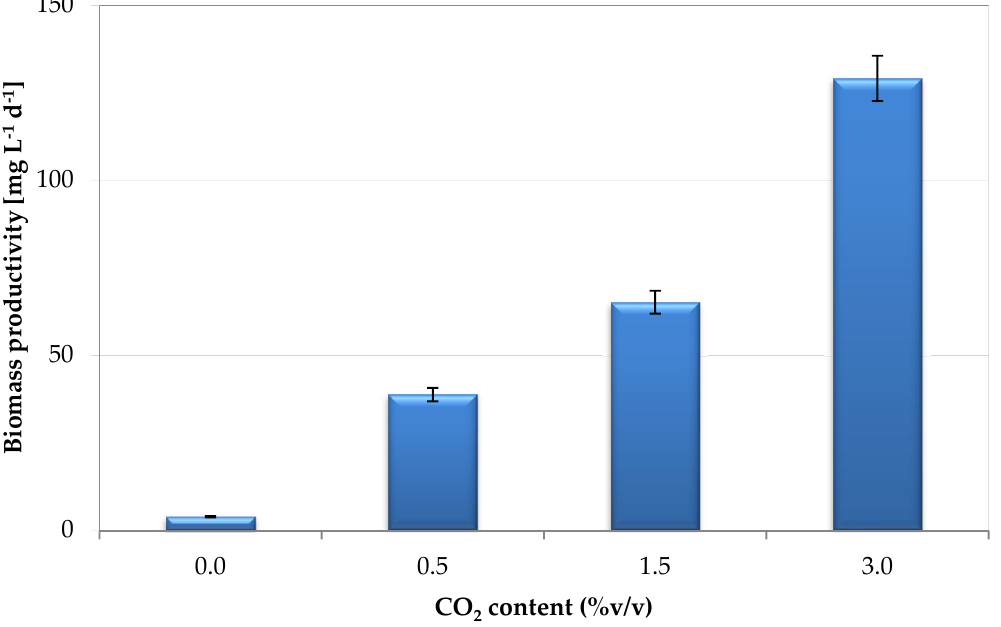
Figure 3. E ff ect of CO 2 content on S. almeriensis biomass Figure 3. Effect of CO 2 content on S. almeriensis biomass productivity. Figure 3. Effect of CO 2 content on S. almeriensis biomass productivity.